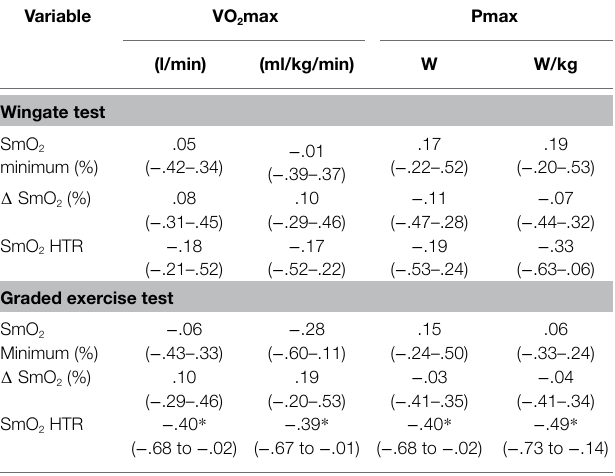
TABLE 5 | Spearman’s rank correlation coefficient values between VO 2 maxand Pmax and selected indices of muscle oxygenation recorded during the Wingate and graded exercise tests in the group of female and male speed skaters ( n = 27).